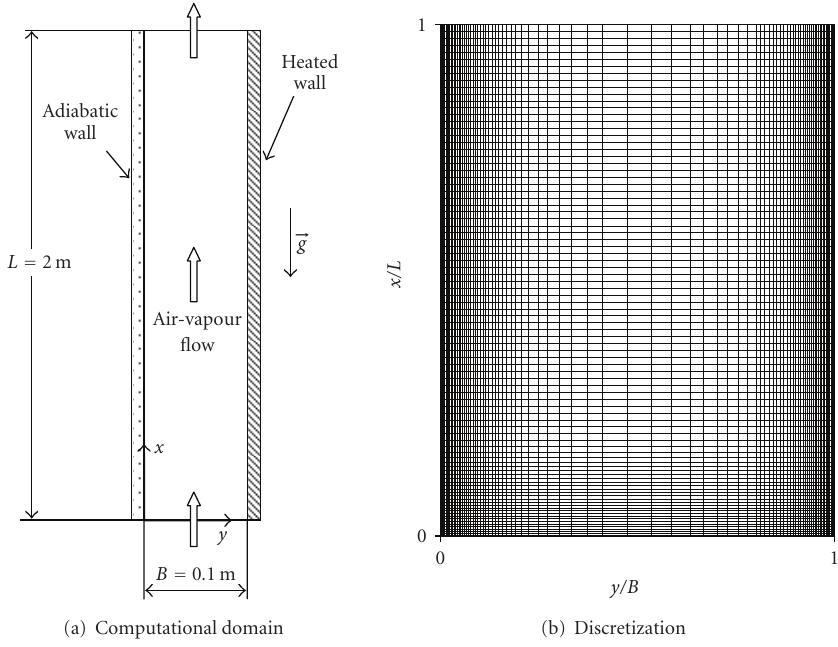
Figure 6: Computational domain and discretization of the channel of the EFFE experimental facility for the FLUENT code. Table 1: Boundary conditions for the dry and wet EFFE tests addressed by FLUENT calculations [15]. Test